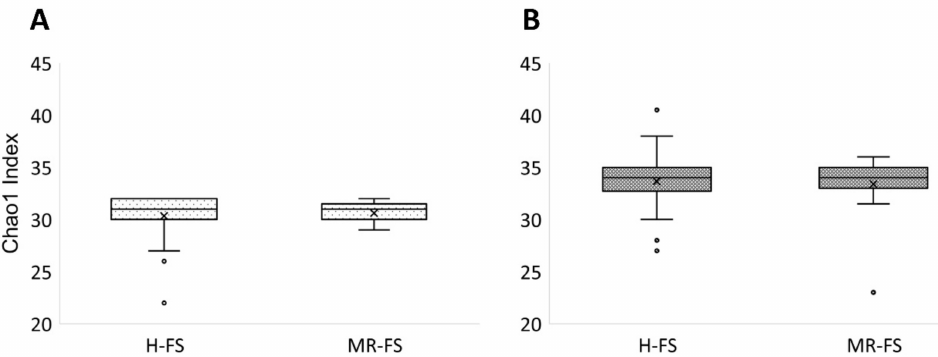
Figure 3. α -diversity plots calculated with the Chao1 index at the genus ( A ) and family ( B ) level.